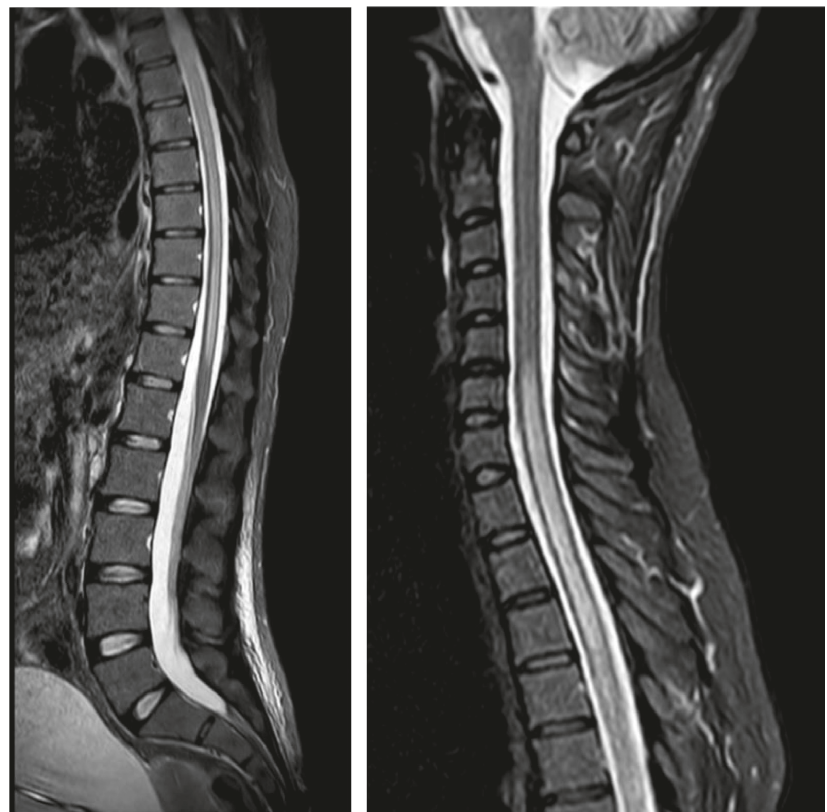
Figure 1: STIR view in magnetic resonance imaging of the patient’s spinal cord indicates longitudinally extensive transverse